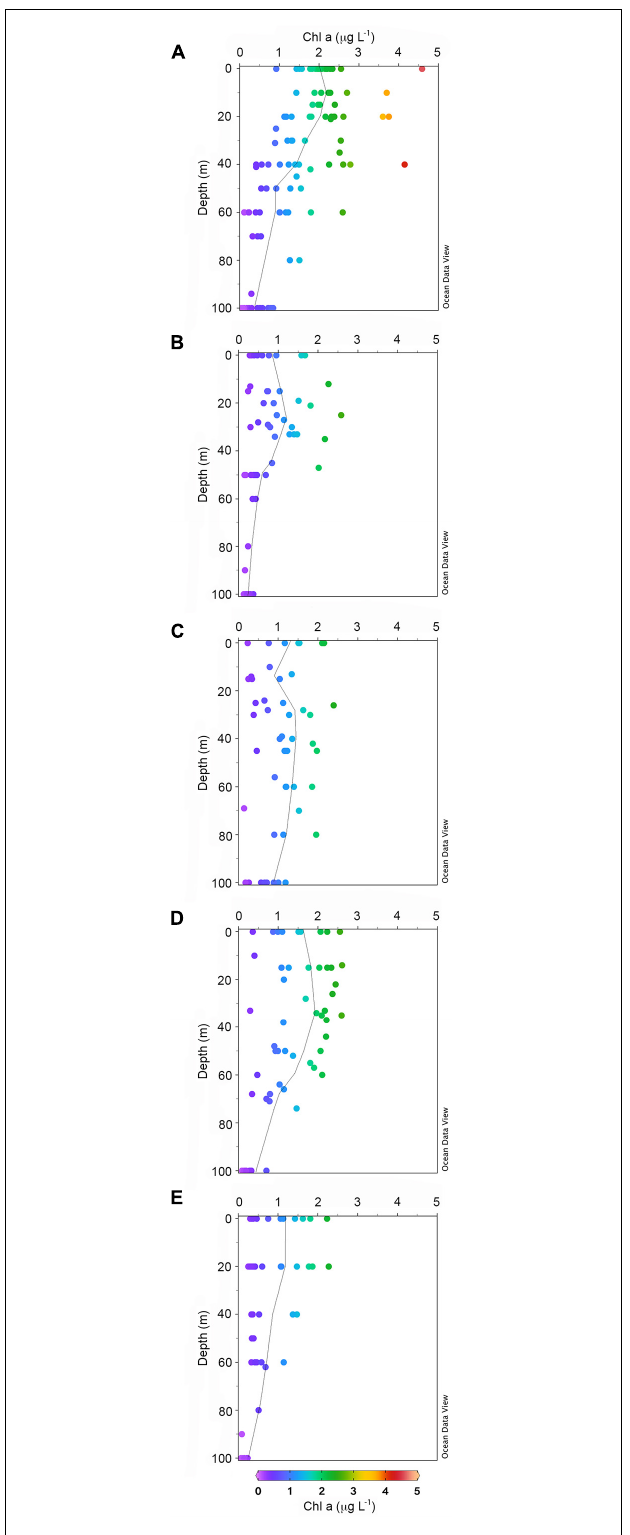
FIGURE 4 | Mean vertical profiles and scatter plot of chl a (mg L − 1 ) for each sub-system: Area 1 (A) , Area 2 (B) , Area 3a (C) , Area 3b (D) , Area 4 (E) . The black line indicates the mean chl a concentration of the entire